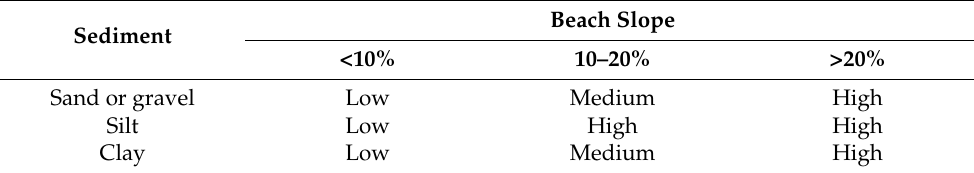
Table A2. Erodibility risk